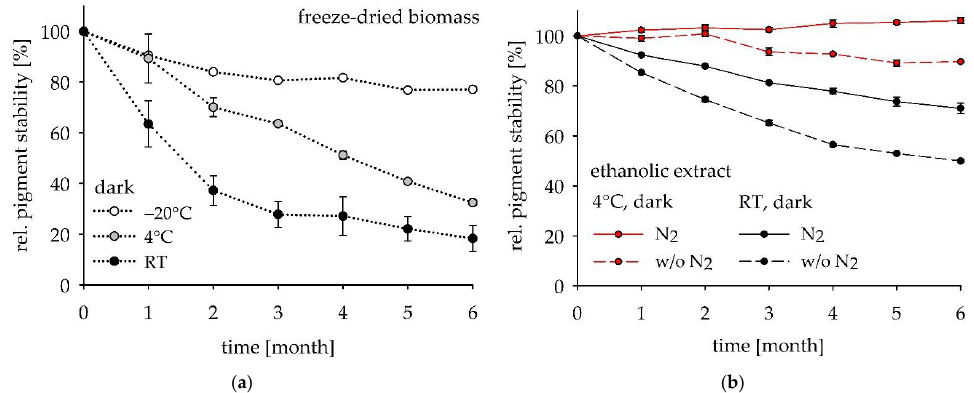
Figure 4. Stability of ethanolic L. sulphureus extracts and freeze-dried biomass over time, stored under different conditions. The difference in absorbance compared to t 0 is displayed as the percentage of remaining absorbance. Stabilities of ( a ) freeze-dried biomass stored at different temperature conditions in the dark; ( b ) ethanolic extracts stabilized with nitrogen.